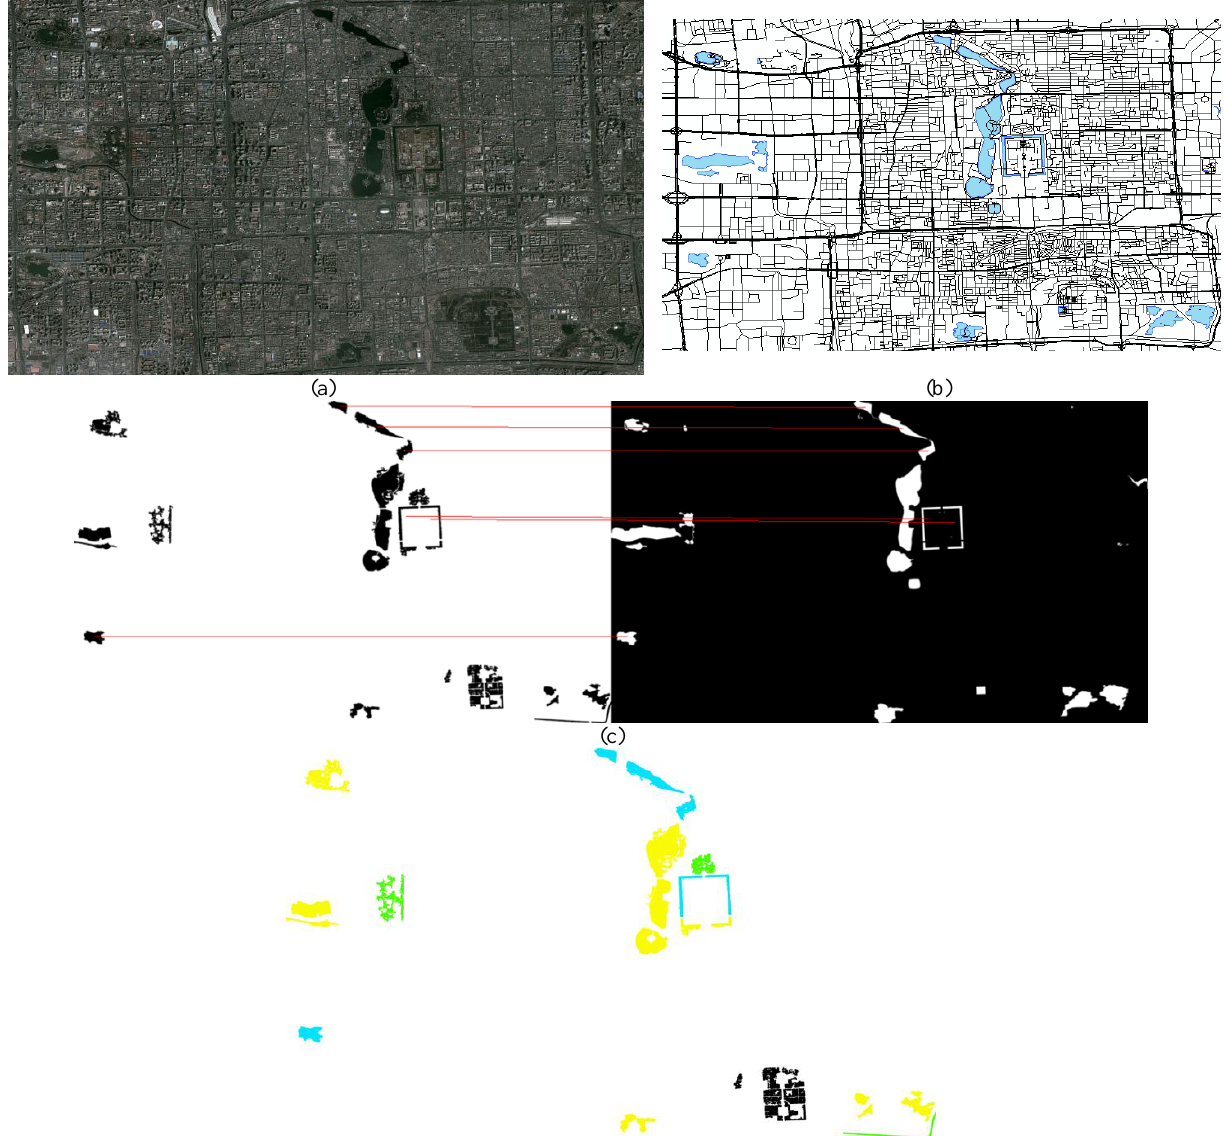
Figure.4 Registration and water-body extraction result of data set B. (a) optical image. (b) OSM data. (blue objects represent data of water layer) (c) Registration results (left is initial extraction results; right is GIS data of water-bodies; red lines represent matching relations). (d) final water extraction result (blue objects represent unchanged water-bodies, yellow objects represent changed ones and green objects represent newly added